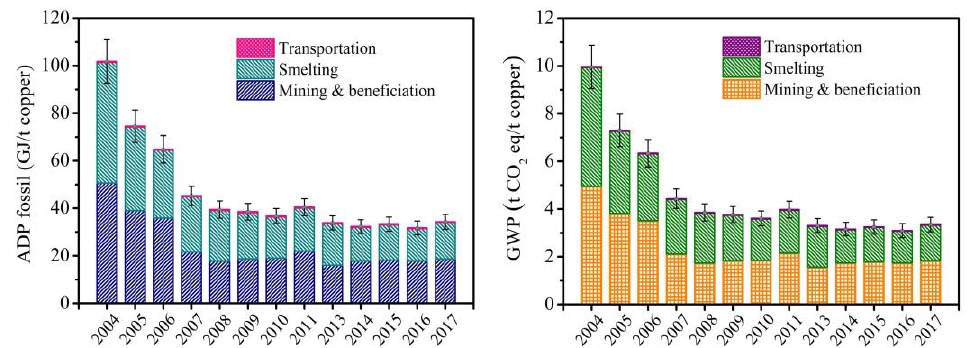
Figure 3. The variation trends of the ADP fossil and GWP from 2004 to 2017.